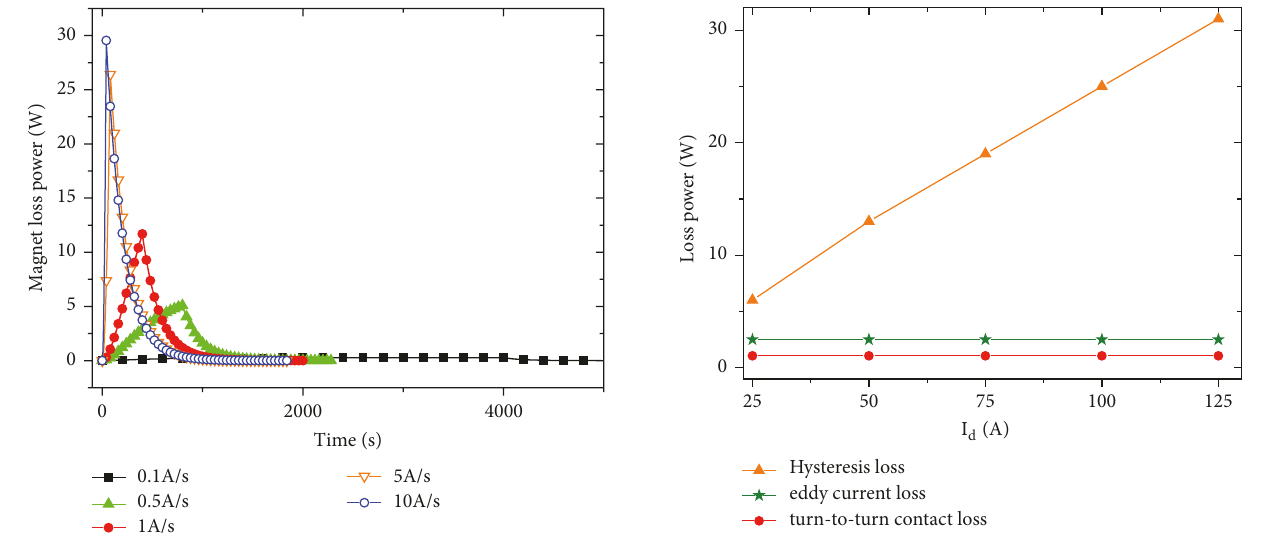
Figure 10: Total thermal loss power of the magnet along with time under different charging rates.